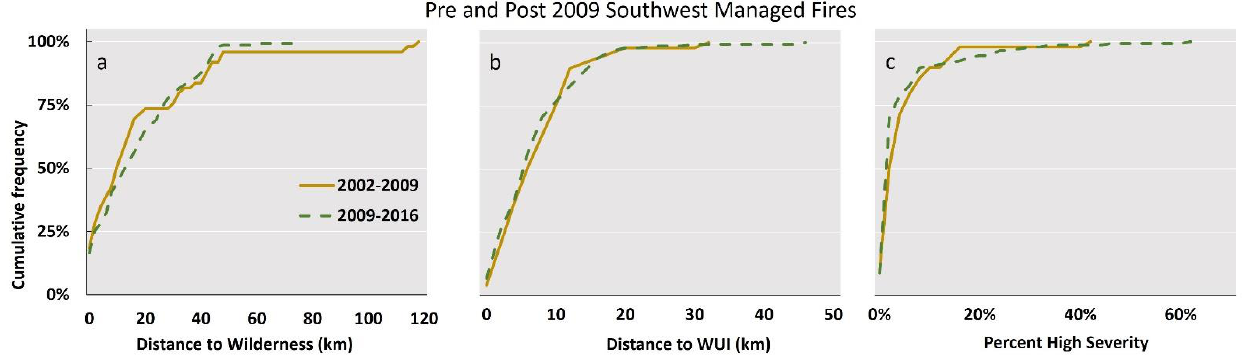
Figure 6. Comparison of managed wildfires in the Southwest before (2002–2008) and after (2009–2016) the 2009 policy guidance based on ( a ) distance to wilderness, ( b ) distance to WUI, and ( c ) the percentage of high-severity burn area. In the Southwest, the geographic characteristics of managed wildfires did not differ between before and after the implementation of the 2009 policy